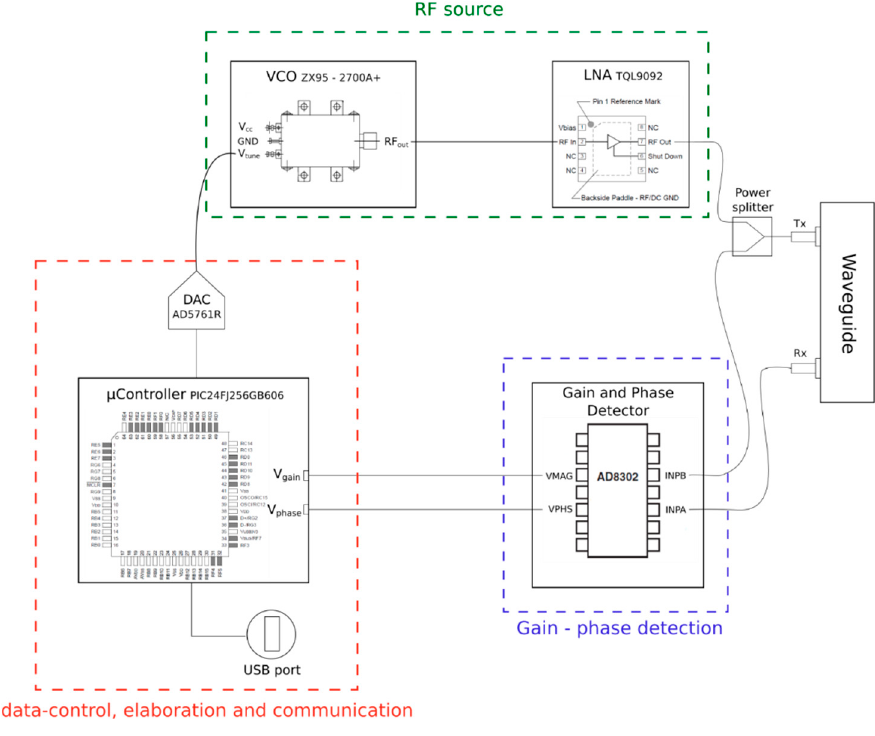
Figure 3. Electronic system layout. Sensors 2020 , 20 , x FOR PEER REVIEW